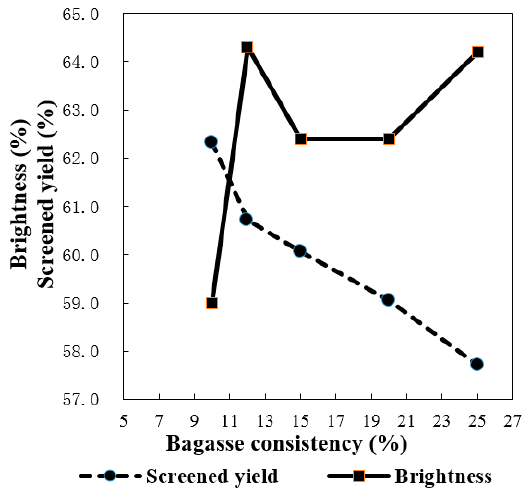
Figure 5. Effect of bagasse consistency on screened yield and brightness (active alkali charge 23%, time to maximum temperature 55–65 min, time at T max 180 min, initial pressure of oxygen 0.6 MPa, and MgSO 4 charge 0.5%, while the bagasse consistency varied as 10%, 12%, 15%, 20%, and 25%, respectively). Molecules 2016 , 21 , 85